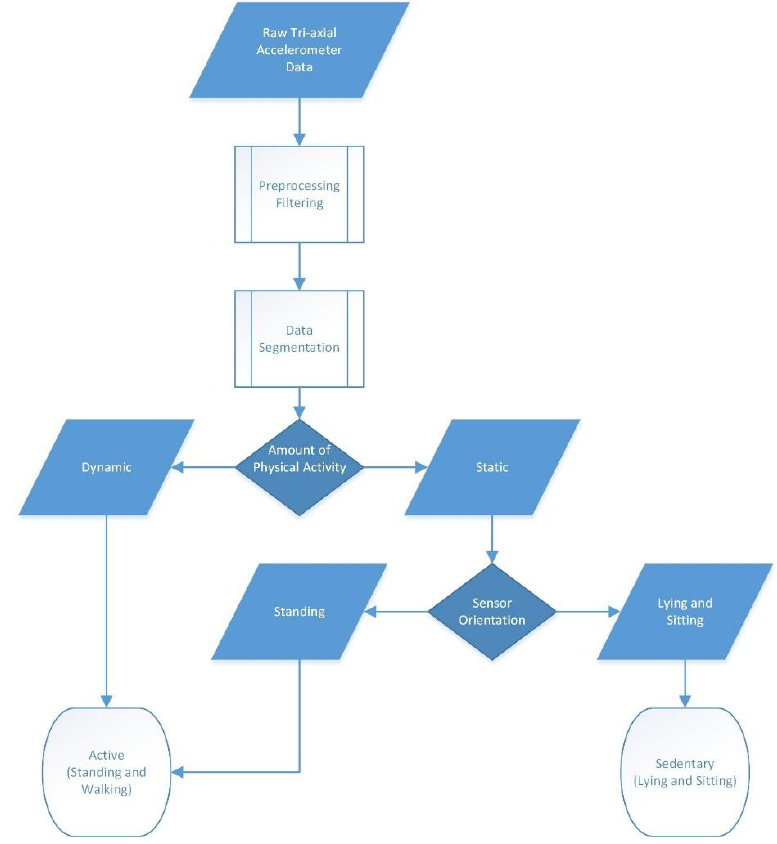
Figure 7. Data processing—a schematic overview of the physical activity classification algorithm for the accelerometer worn on the upper leg location.